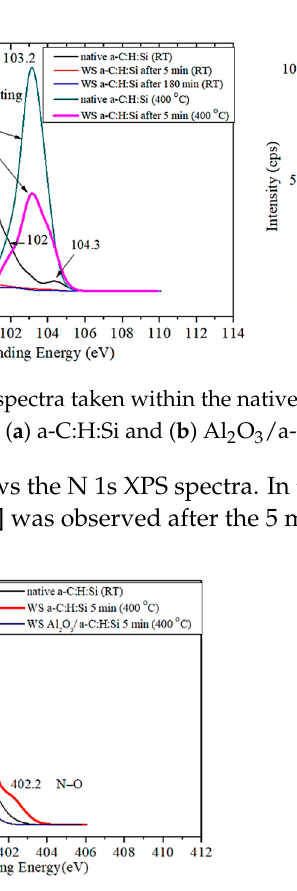
Figure 10. O 1s XPS spectra taken within the native and wear scars surfaces after sliding tests at RT and 400 °C on the ( a ) a-C:H:Si and ( b ) Al 2 O 3 /a-C:H:Si coatings.